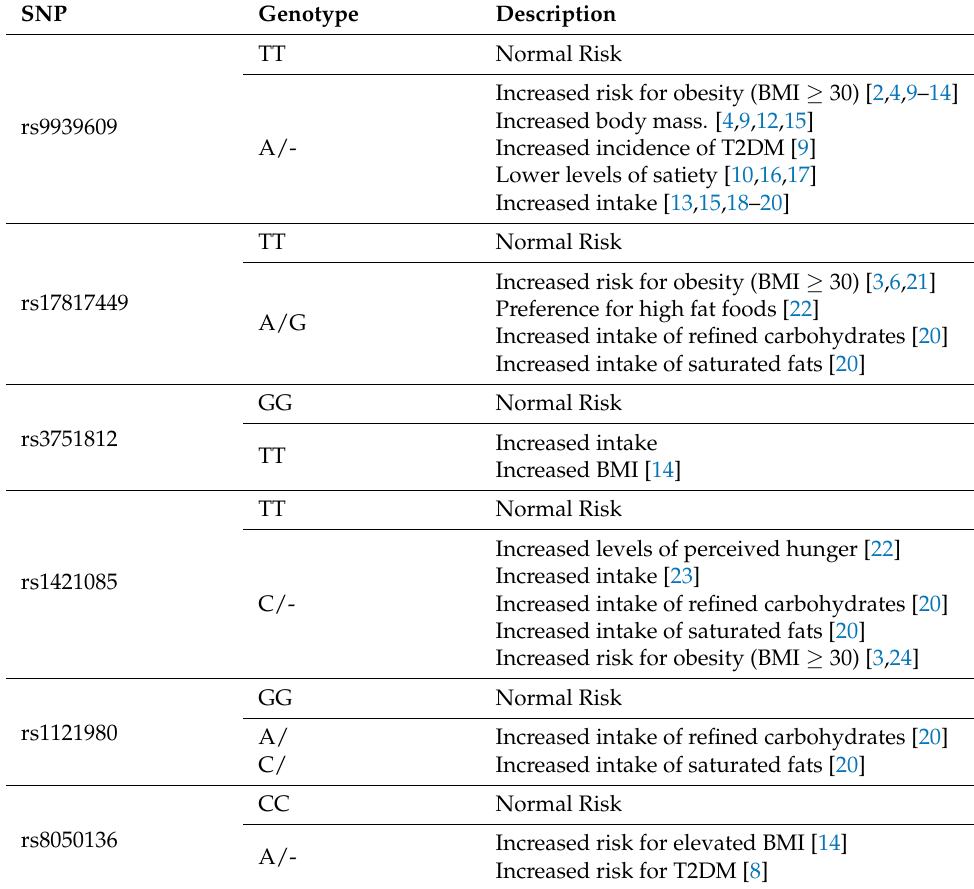
Table 1. Common FTO